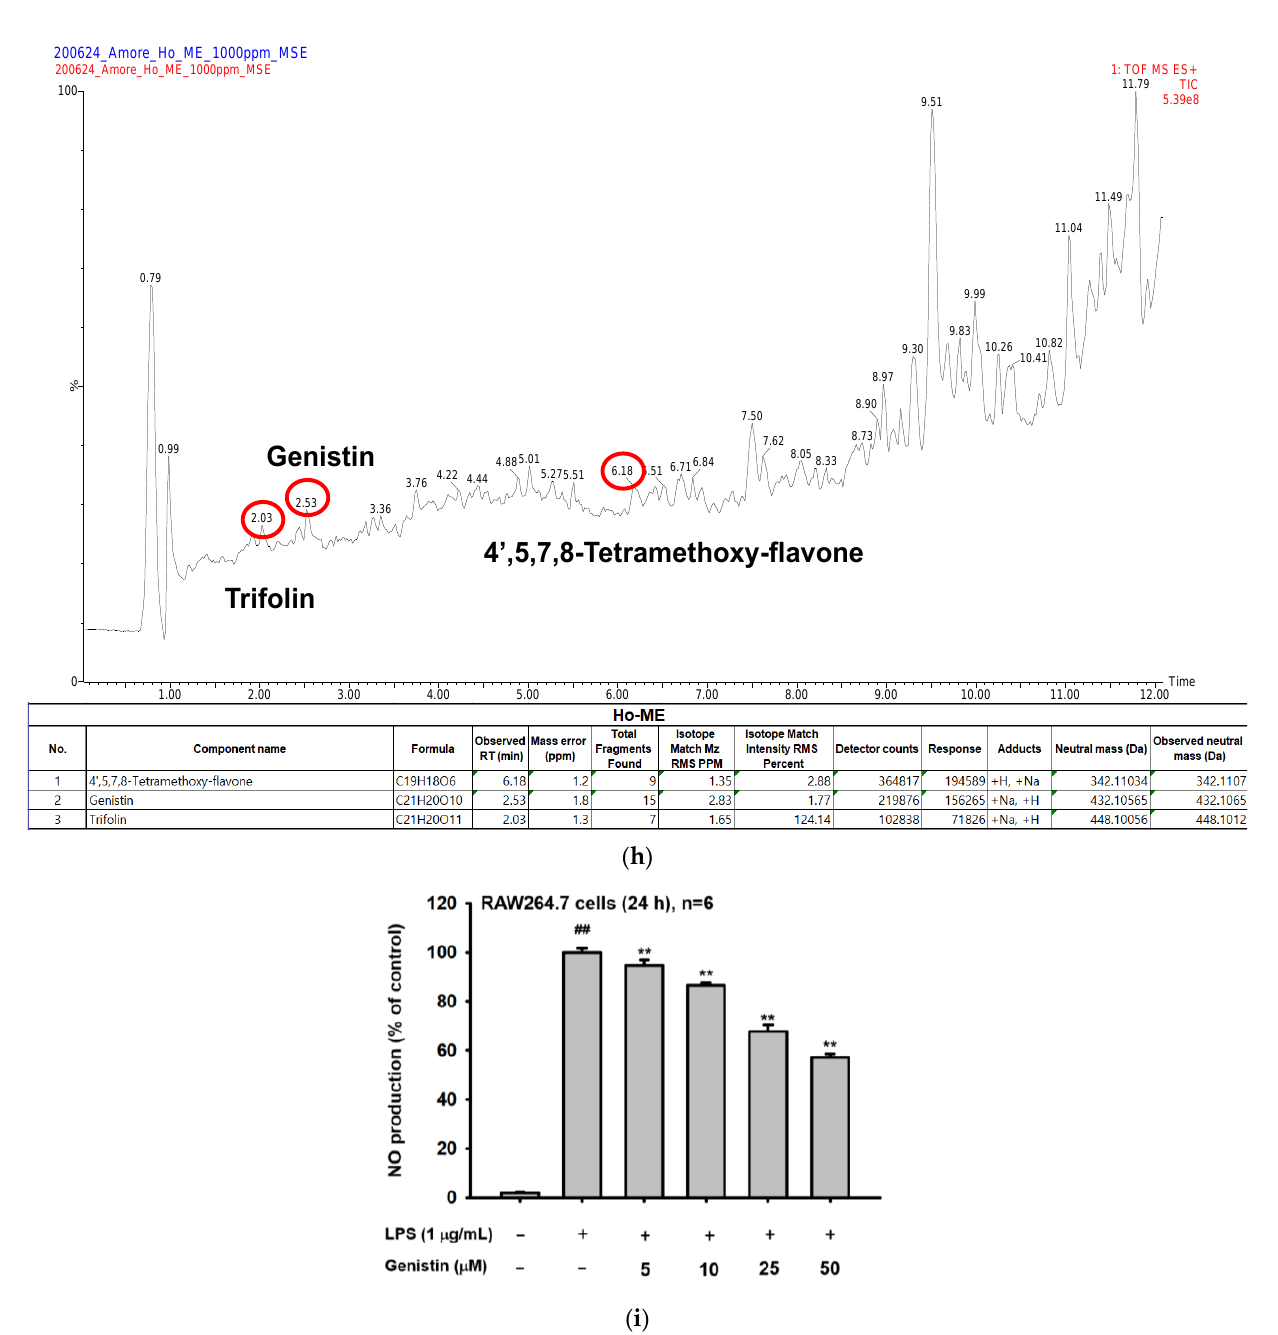
Figure 1. Ho-ME alleviated NO production in activated macrophages. ( a , b ) NO production level was assessed according to Ho-ME treatment in RAW264.7 cells stimulated by LPS for 24 ( a ) and 12 h ( b ). ( c ) The ability of L-NAME, a NOS inhibitor, to suppress the production of NO in LPS-treated RAW264.7 cells was tested by NO production assay. ( d , e ) NO inhibitory level of Ho-ME was observed in ( d ) PAM3CSK4- and ( e ) Poly I:C-treated RAW264.7 cells. ( f , g ) Cell viability of RAW 264.7 cells on Ho-ME treatment was assessed by MTT assay. ( h ) Phytochemical fingerprinting profile of Ho-ME was obtained by liquid chromatography-quadrupole time-of-flight mass spectrometric (LC- QTOF/MS) analysis. ( i ) Suppression of NO by genistin treatment was confirmed by NO assay under the same conditions. All data are presented as mean ± standard deviation (SD) calculated from the indicated number of independent samples. ##: p < 0.01 compared to the non-stimulated group, and **: p < 0.01 compared to the control groups. In addition, time-of-flight mass spectrometry (TOF-MS) was performed to identify the main actors in the Ho-ME-mediated anti-inflammatory effects. Trifolin, genistin, and